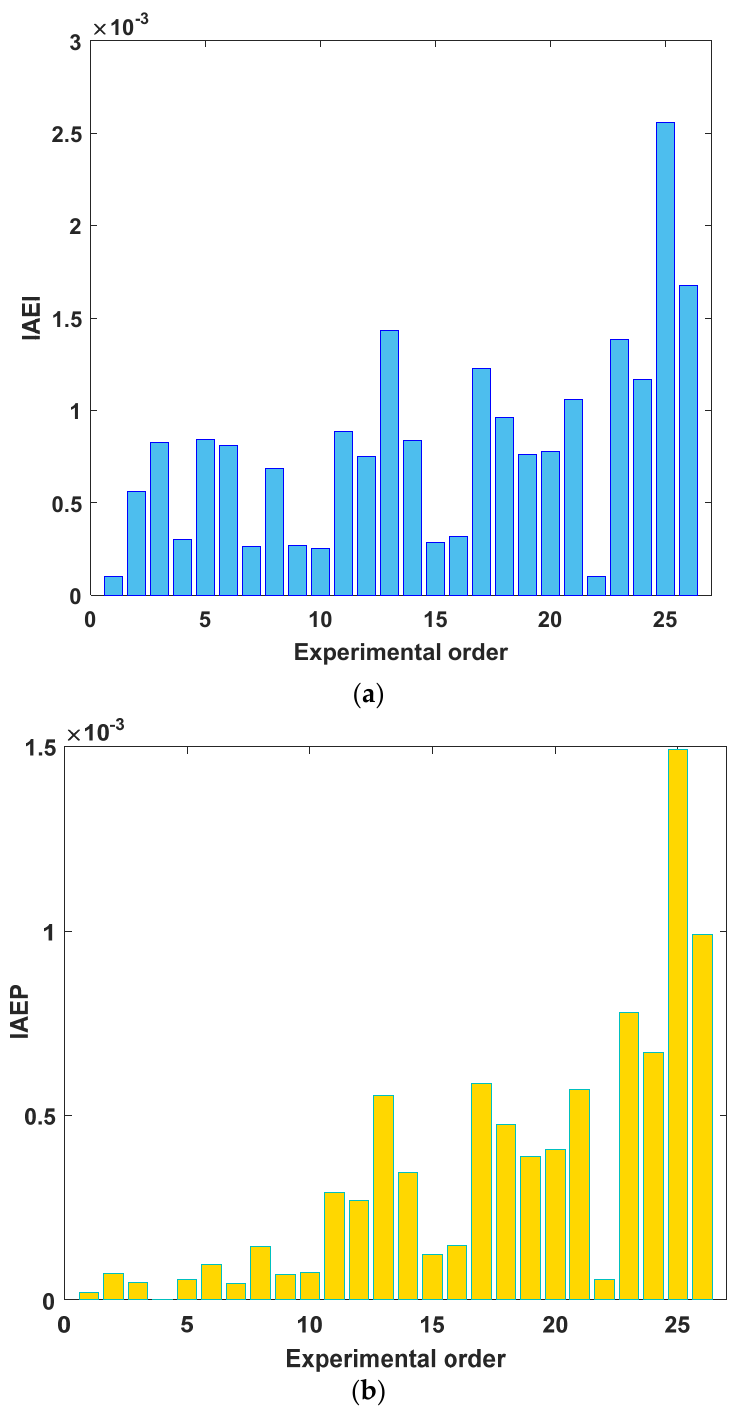
Figure 14. Individual absolute errors for current and power by the MECPO for DDM. ( a ) Individual absolute errors for current. ( b ) Individual absolute errors for power.